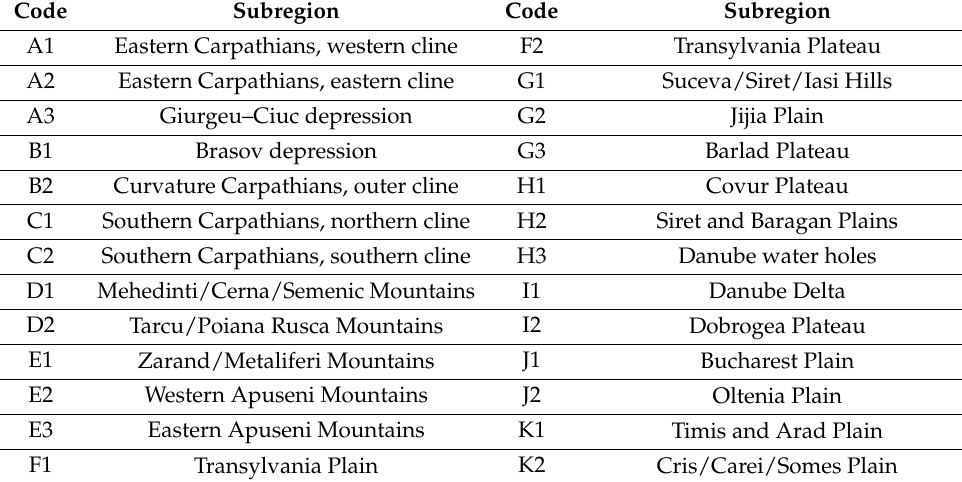
(Table 4). Of the total number of ecological sectors, 10 represent forest types growing in extreme vegetation conditions (located in extreme site conditions such as climate and soil), corresponding to the basic material included in the category ‘Identified source’, and 15 forest types under normal vegetation conditions, corresponding to the category ‘Selected source’ [30]. Table 3. Provenance subregions.